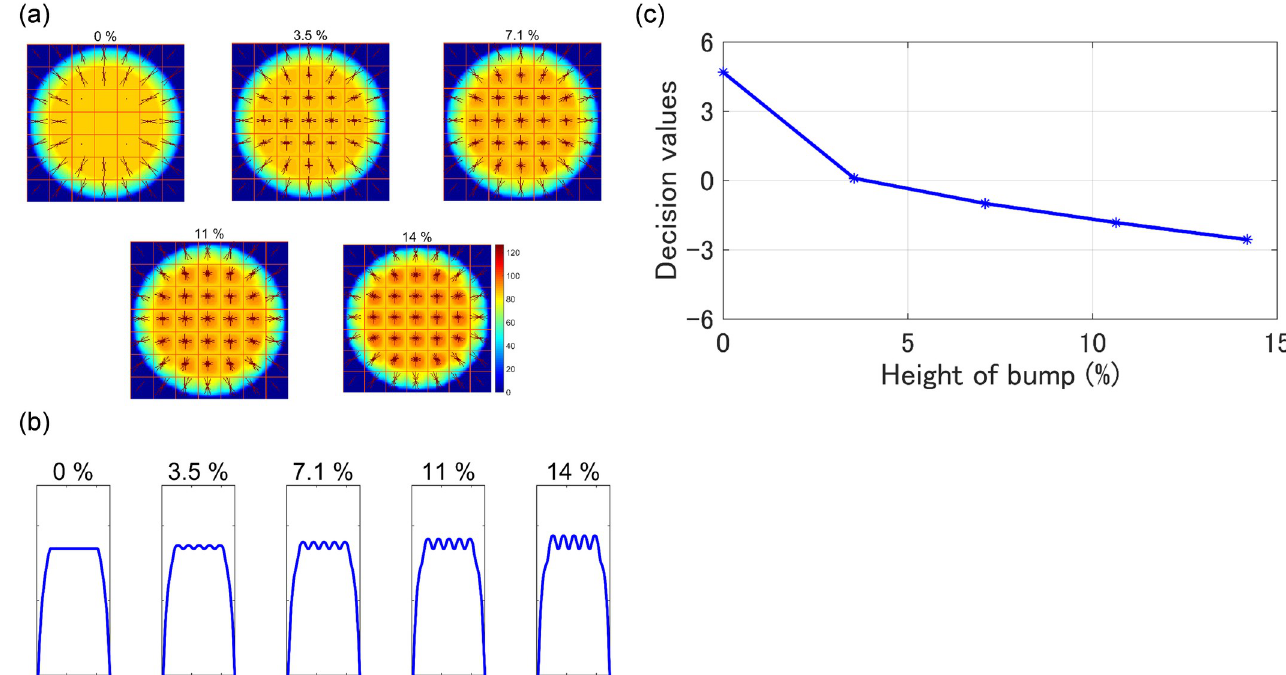
Fig 12. Classifications of heterogeneous phantoms. (a) Visualized HOG features superimposed on OPL/PL represented in pseudo color. The numbers above the figures are bump heights (%). (b) Cross sections of the phantoms. (c) Decision values of simulated phantoms with respect to bump heights are determined by the SVM classifier trained on HOG features of